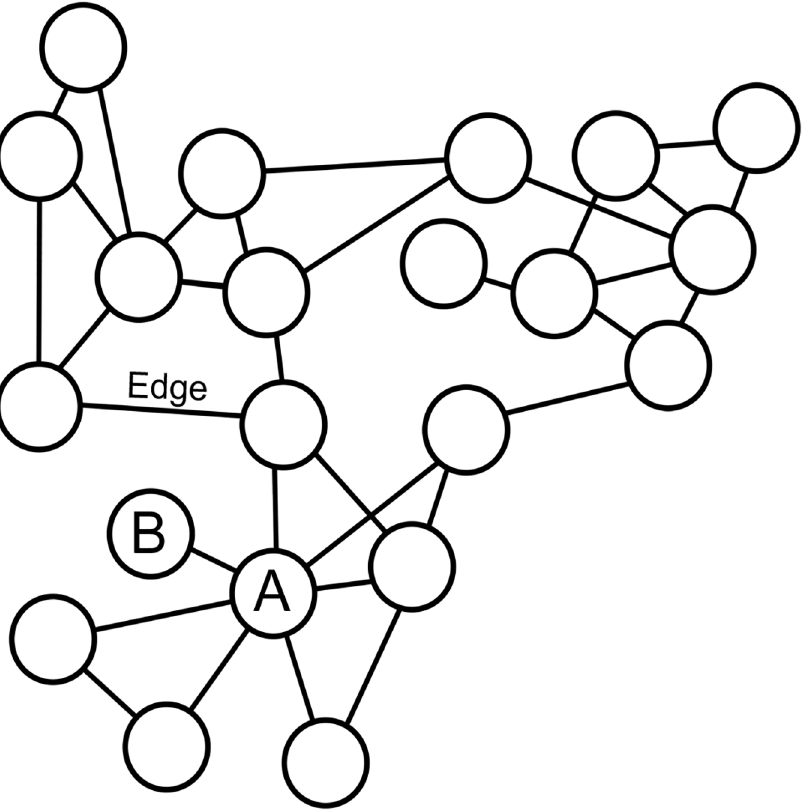
Fig 1. Simplified representation of a hypothetical coexpression network. Node A represents a hub gene whilenode B represents a peripheral gene. Lines connectingnodes represent network edges, and reflect correlationsin